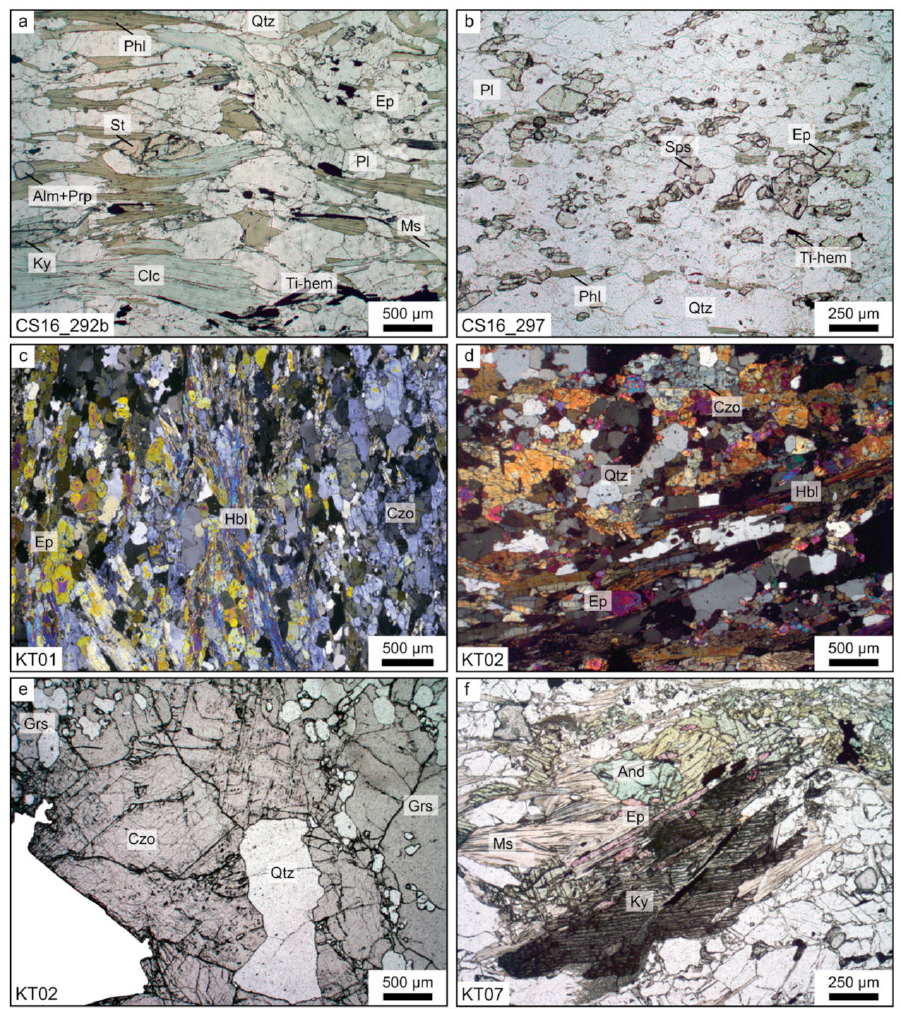
Figure 6. Main mineralogical assemblages from the Trikorfo area. ( a ) Biotite–garnet–kyanite– staurolite–plagioclase-quartz–Ti–hematite paragenesis of the main paragneiss unit modeled with Perple_X. Chlorite (clinochlore / amesite) is a retrogressed phase of phlogopite. Scarce late muscovite and epidote are observed. ( b ) Phlogopite–spessartine–epidote association of the quartz-dominated green horizon parallel to the gneiss foliation. ( c ) Clinozoisite and epidote layers and secondary amphibole in sample KT01 under XPL. ( d ) Clinozoisite–epidote–hornblende in sample KT02 under XPL. ( e ) Grossular-quartz–clinozoisite (clinothulite) microscopic view (PPL) of sample KT02. ( f ) Secondary Mn-rich epidote, orange kyanite and green andalusite assemblage of sample KT07 under PPL. Mineral abbreviation: Almandine + pyrope (Alm + Prp), Andalusite (And), Clinochlore / amesite (Clc), Clinozoisite (Czo), Epidote (Ep), Grossular (Grs), Hornblende (Hbl), Kyanite (Ky), Muscovite (Ms), Phlogopite (Phl), Plagioclase (Pl), Quartz (Qtz), Staurolite (St) and Ti-hematite